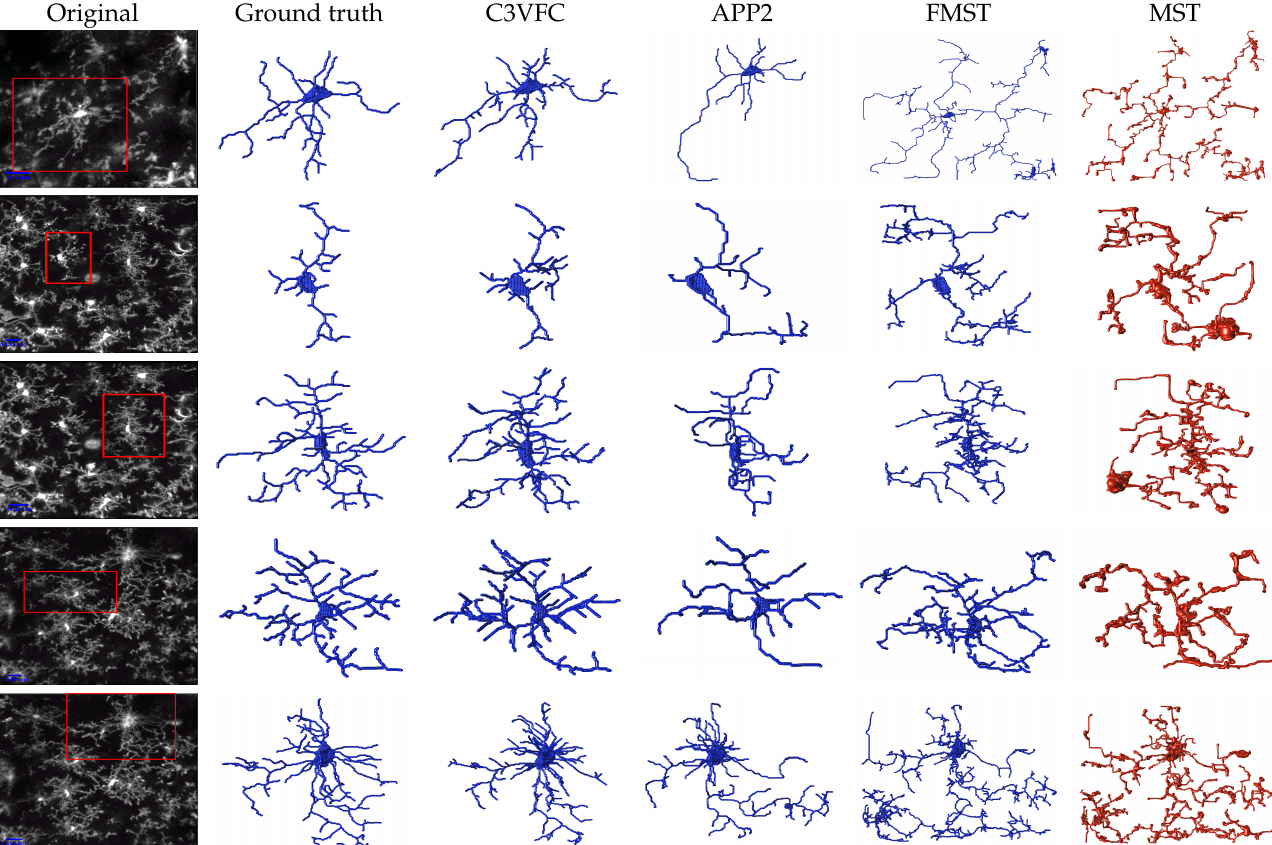
Figure 7. Reconstruction results of 3D microglia images. The first column on the left is the original image with the region of interest boxed out on the left. The following columns show the 3D reconstruction in the SWC